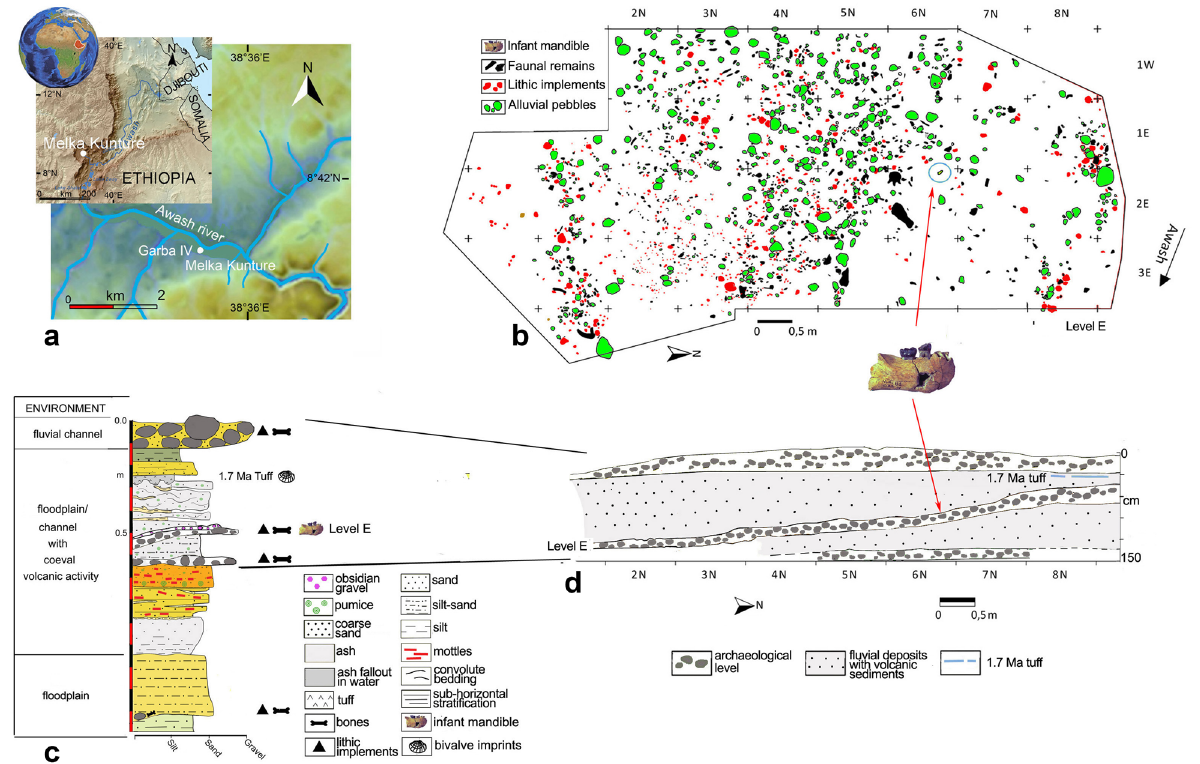
Figure 1. Garba IV site. ( a ) Location map of Melka Kunture and the Garba IV site (modified after https:// upload. wikim edia. org/ wikip edia/ commo ns/2/ 24/ Africa_ satel lite. jpg, https:// commo ns. wikim edia. org/ wiki/ File: Awash river map. png, and https:// data. humda ta. org/ datas et/ ethio pia- eleva tion- model using QGIS software; https:// qgis. org); ( b ) Plan of archaeological level E with position of GAR IVE (modified after Fig. 4A from Ref. 27 ); ( c ) Stratigraphic log of Garba IV (Photoshop CS3; https:// www. adobe- photo shop); ( d ) schematic cross- section of the archaeological levels (modified after Fig. 3B from Ref. 27 ). The map of the Awash River (https:// commo ns. wikim edia. org/ wiki/ File: Awash river map. png) is licensed under the Creative Commons Attribution- ShareAlike 3.0 license. The license terms can be found on the following link: http:// creat iveco mmons. org/ licen ses/ by- sa/3.